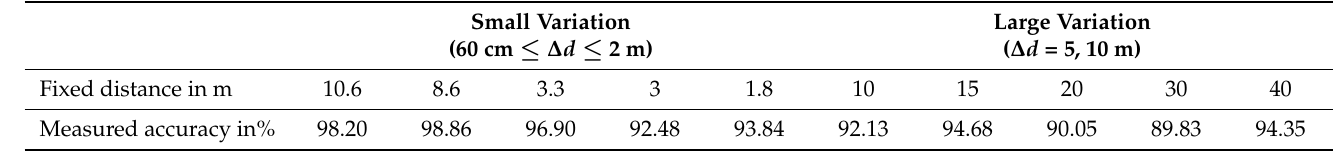
Figure 5. Experimental investigation on the Decawave measuring stability, representation of mea- surement series over a fixed distance: ( a ) small distance variation and ( b ) large distance variation. Table 2. Decawave measurement accuracy under LoS.